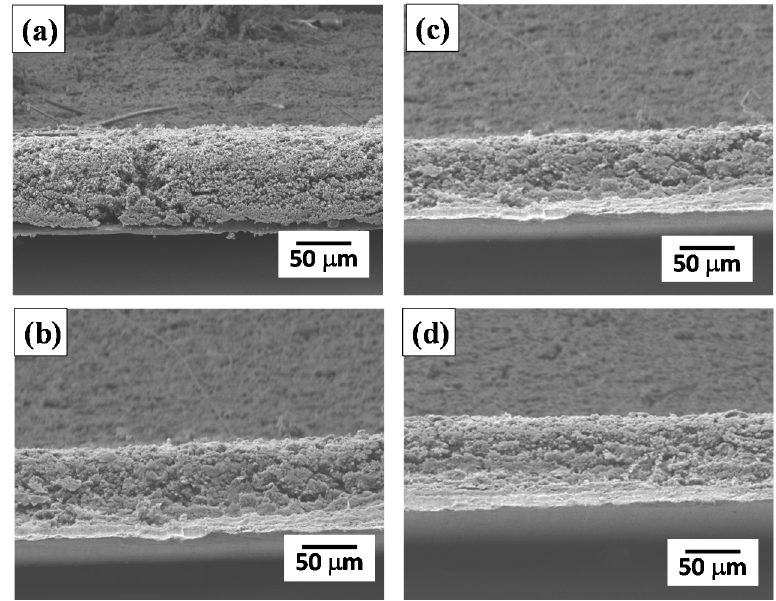
Figure 4. Cross-sectional FE-SEM images of different GN-based heat sinks: ( a ) GN–CNT1; ( b ) GN–G1; ( c ) GN–CNT2; and ( d ) GN–G2. This reflects that the exfoliation level on as-prepared GNs effectively improves the density of GN stacking layers, thus reducing the porosity of heat sinks.